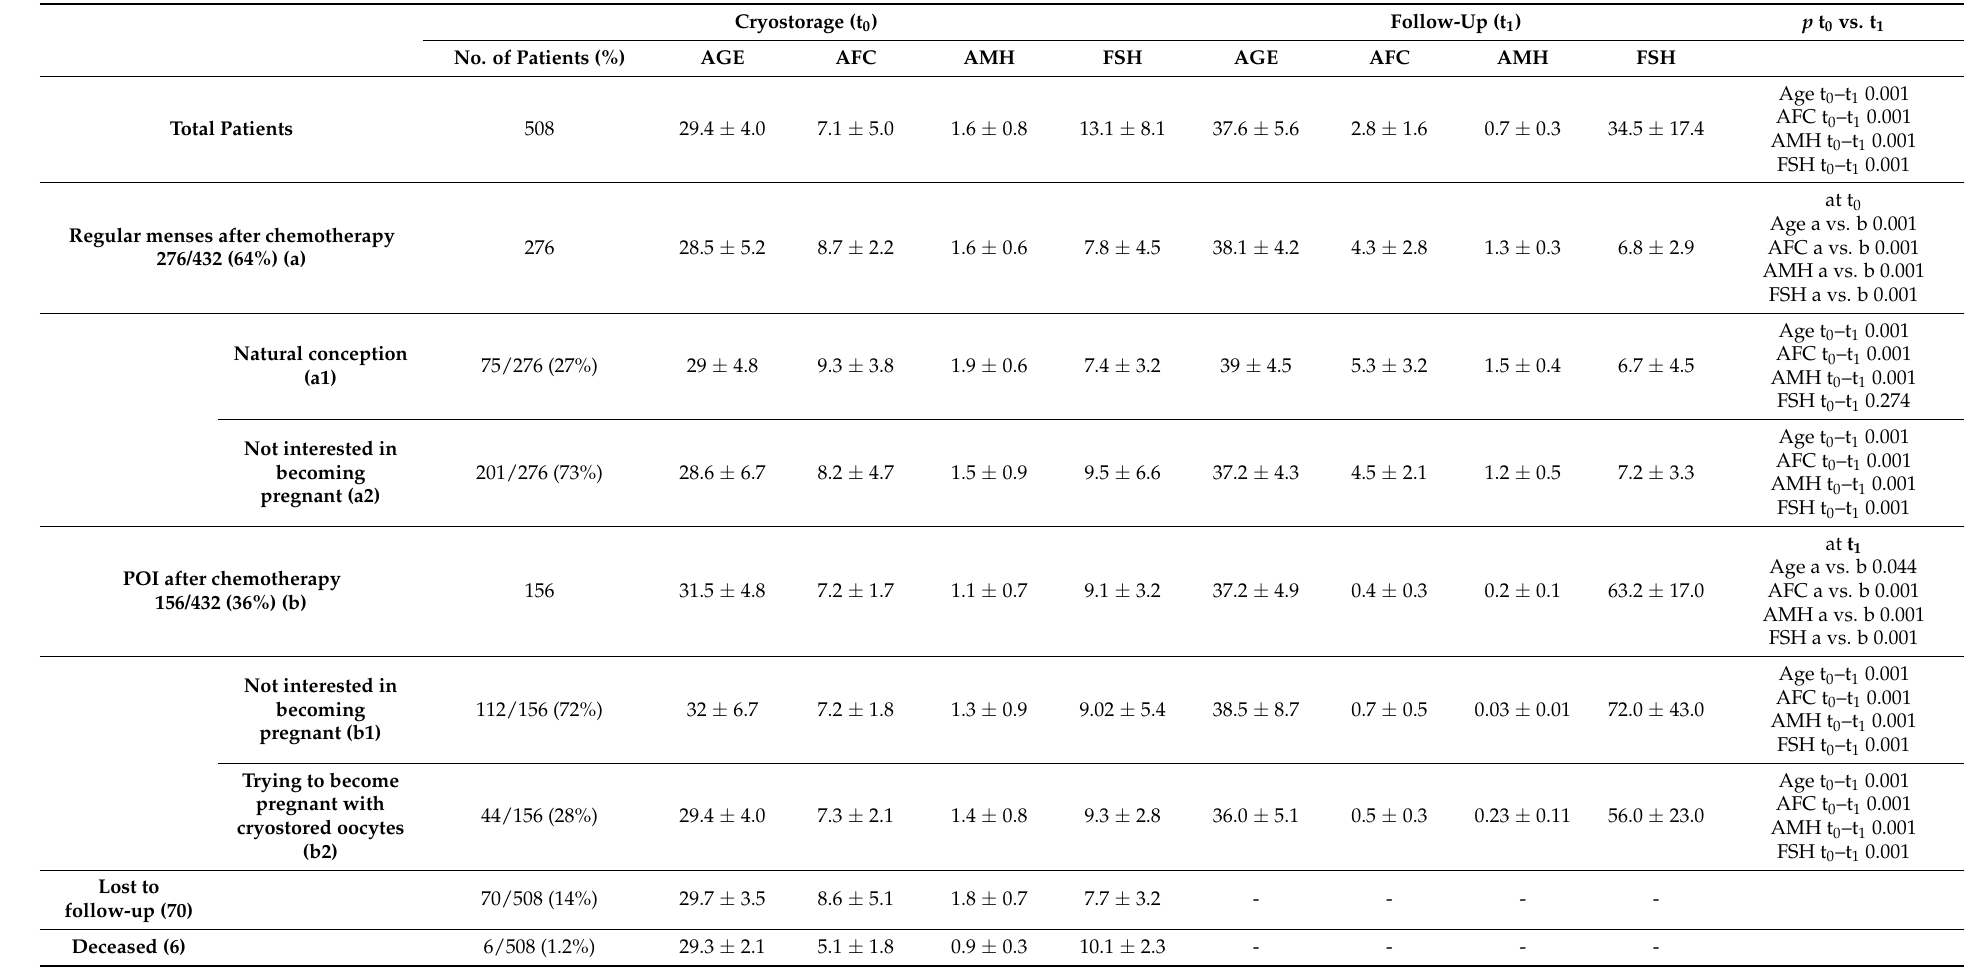
Table 1. Follow-up of oncological patients: comparison of age and ovarian reserve between the time of cryostorage and